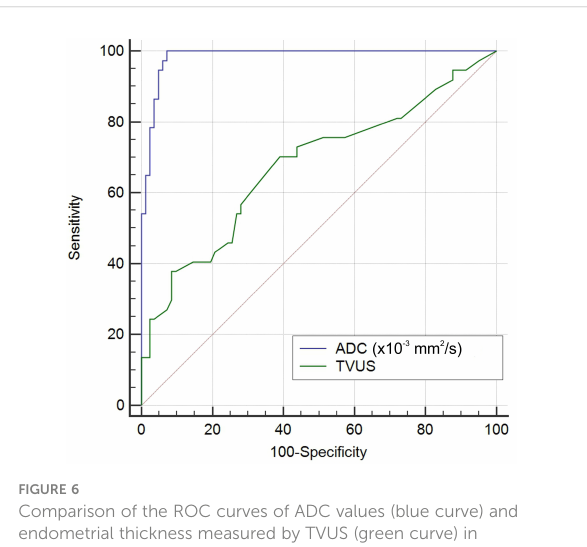
FIGURE 5 ROC curve analysis of ADC values in differentiation between malignant and benign endometrial